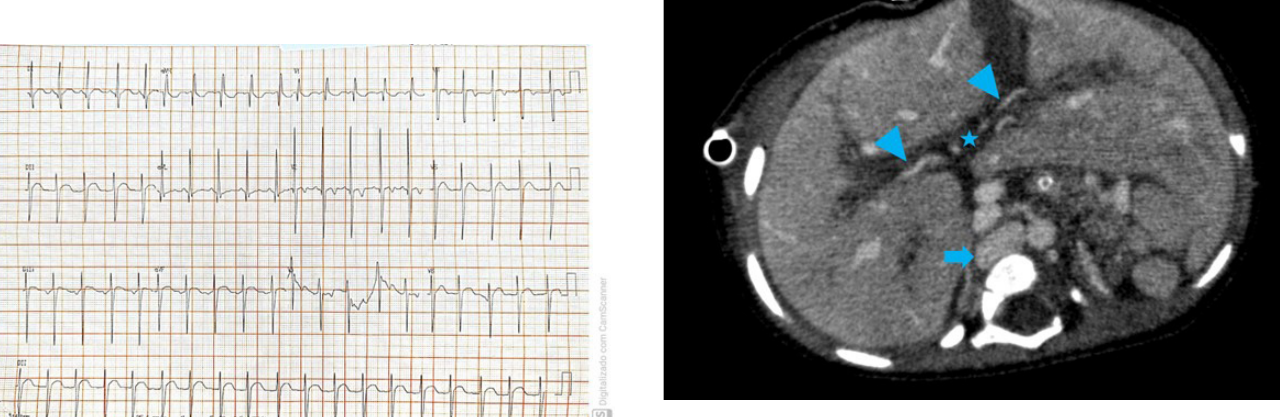
Fig. 3 - Axial image of the upper hemiabdomen in the venous phase of computed tomography showing medialized liver, inferior vena cava (solid arrow) in retrocrural position, cranially bound to the thoracic cavity with the azygos system. In the liver, the typical image of the portal vein or its branches is not identified at the hilum level (*), identifying only the hepatic artery and ectatic intrahepatic branches (arrowheads).